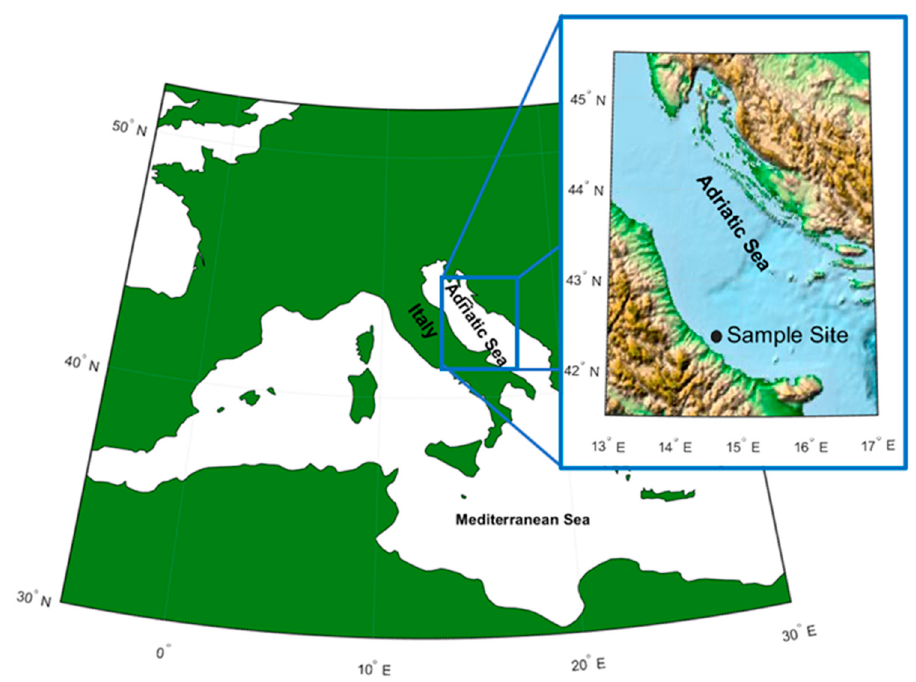
Figure 1. Map of the Adriatic Sea where the pilot study was carried out.